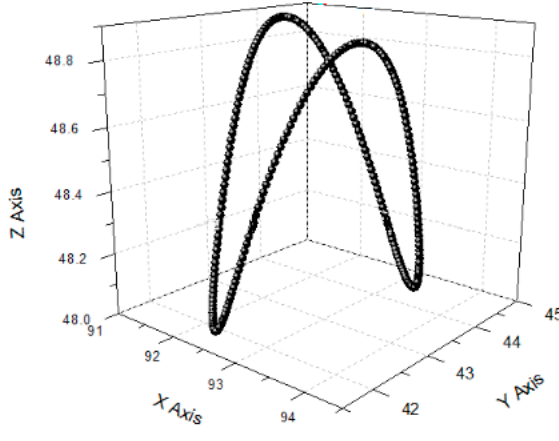
Figure 38. Output trace No. 2.